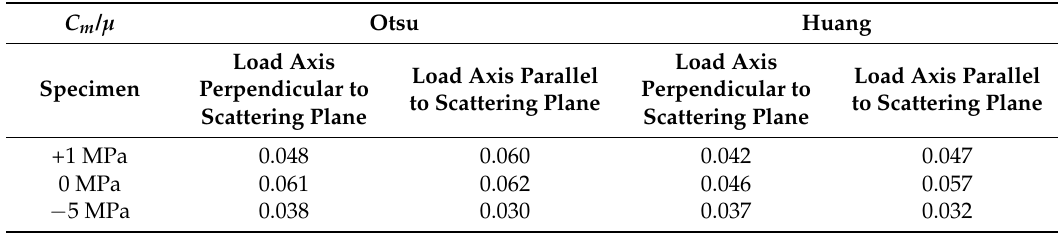
Figure 10. Segmentation of the refraction map for the 1 MPa specimen (Figure 7): ( a ) Mask with Otsu threshold; and ( b ) mask with Huang threshold. Table 3. Normalized refraction value C m / µ as a function of direction for the investigated specimens, calculated using two different segmentation masks (Otsu and Huang).